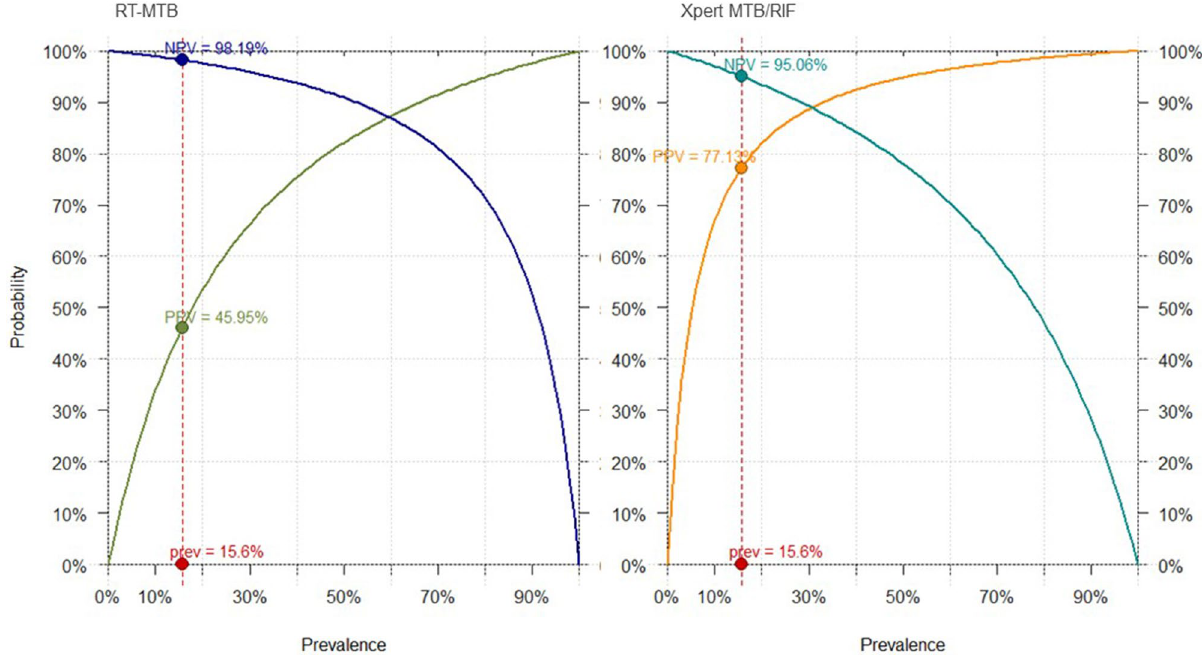
Figure 4. Xpert and RT-MTB PPVs and NPVs by pre-test probability. The prevalence applied has been calculated relying on the microbiological reference standard. NPV negative predicted value, PPV positive predicted value, Pre prevalence.